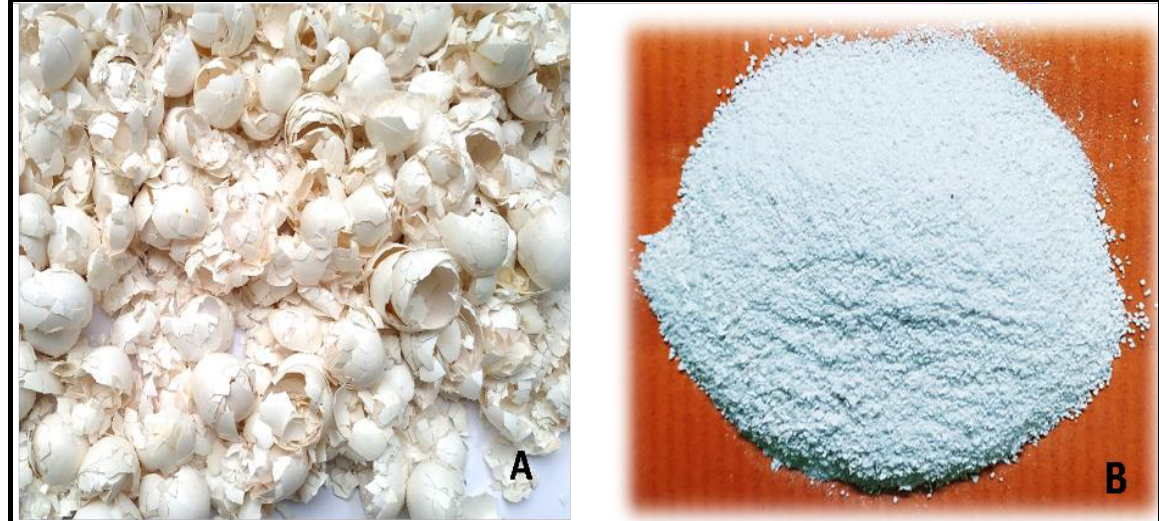
Fig. 1 Chicken egg shell. (A), Egg shell dust